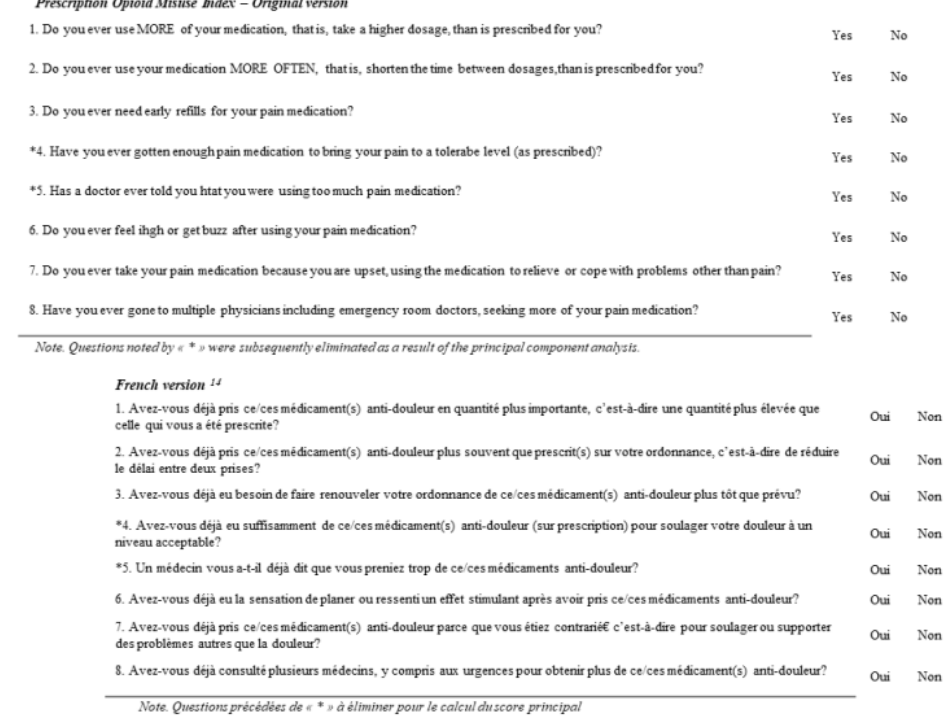
Figure 1. Prescription opioid misuse index, English and French version.